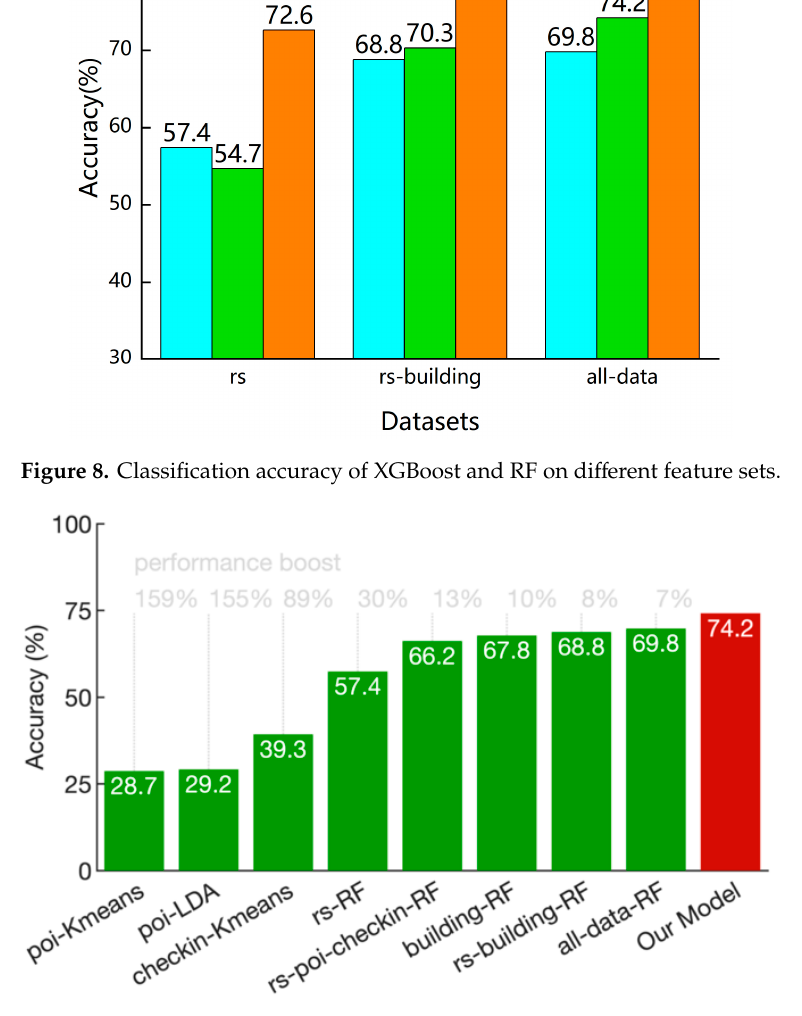
Figure 9. Comparison of model